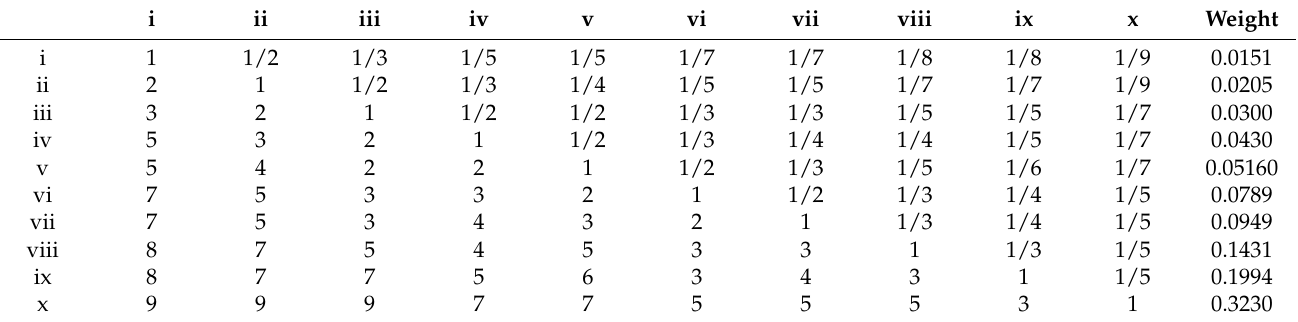
Table 5. AHP pairwise comparison matrix of landslide conditioning factors and corresponding weights, where i = lithology; ii = aspect; iii = geomorphology; iv = drainage density; v = lineament density; vi = soil type; vii = land use and land cover; viii = profile curvature; ix = rainfall; x = slope.